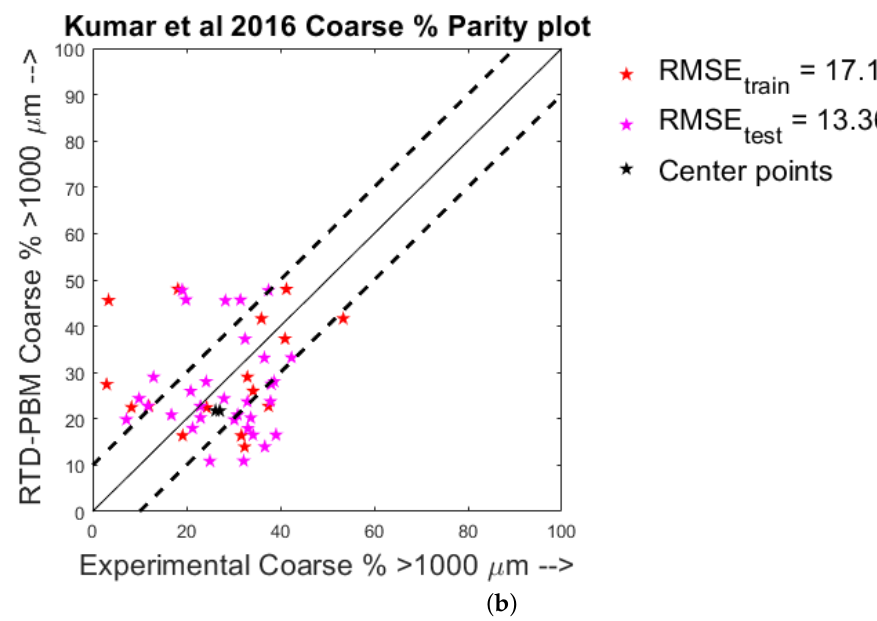
Figure 7. Experimental observations (X) vs. predicted model responses (Y) for outlet fine and coarse granule sizes when the model is trained on the Kumar et al., 2016 [19] dataset. ( a ) fines; ( b ) coarse.